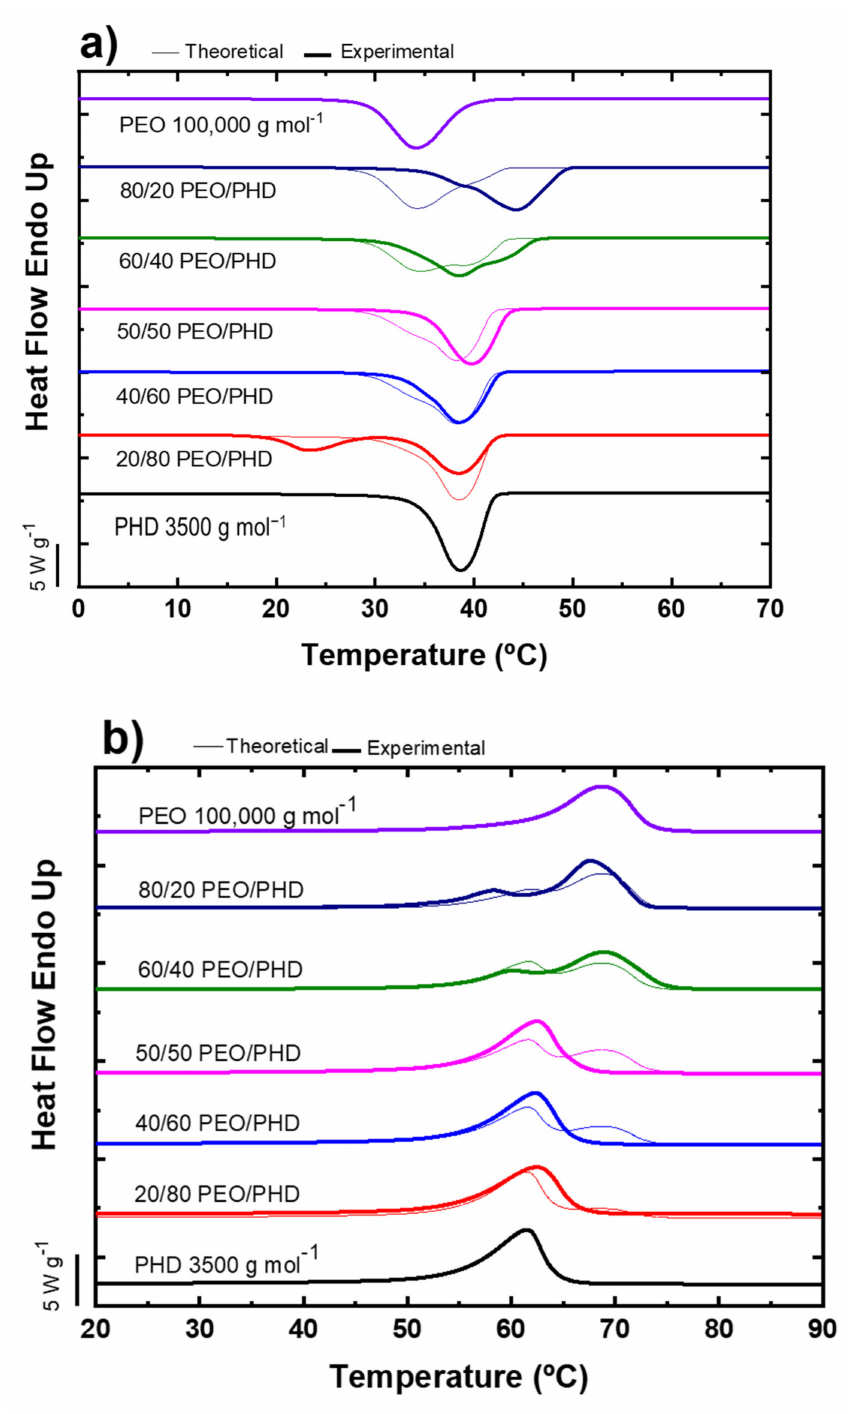
Figure 1. PEO/PHD blends: ( a ) DSC cooling scans at 20 ◦ C min − 1 and ( b ) DSC second heating scans at 20 ◦ C min − 1